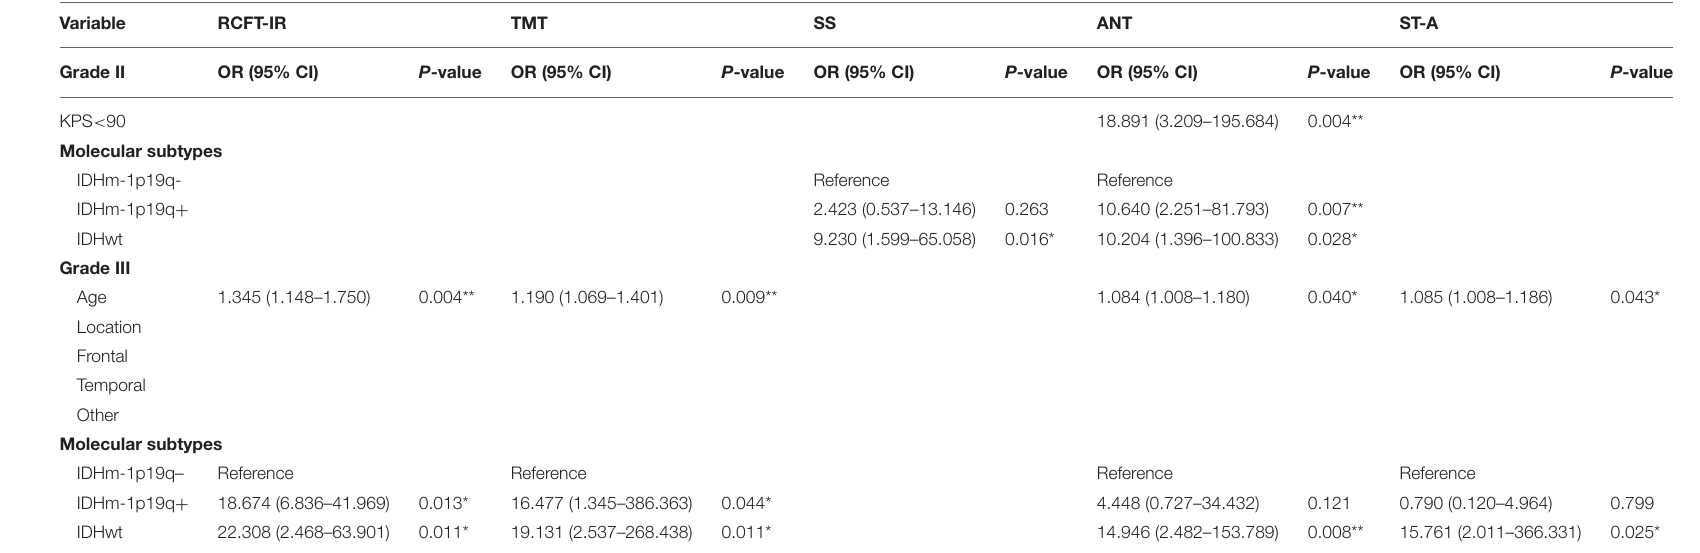
TABLE 9 | Multivariate analysis of clinical and molecular variable in patients with lower-grade glioma. Variable